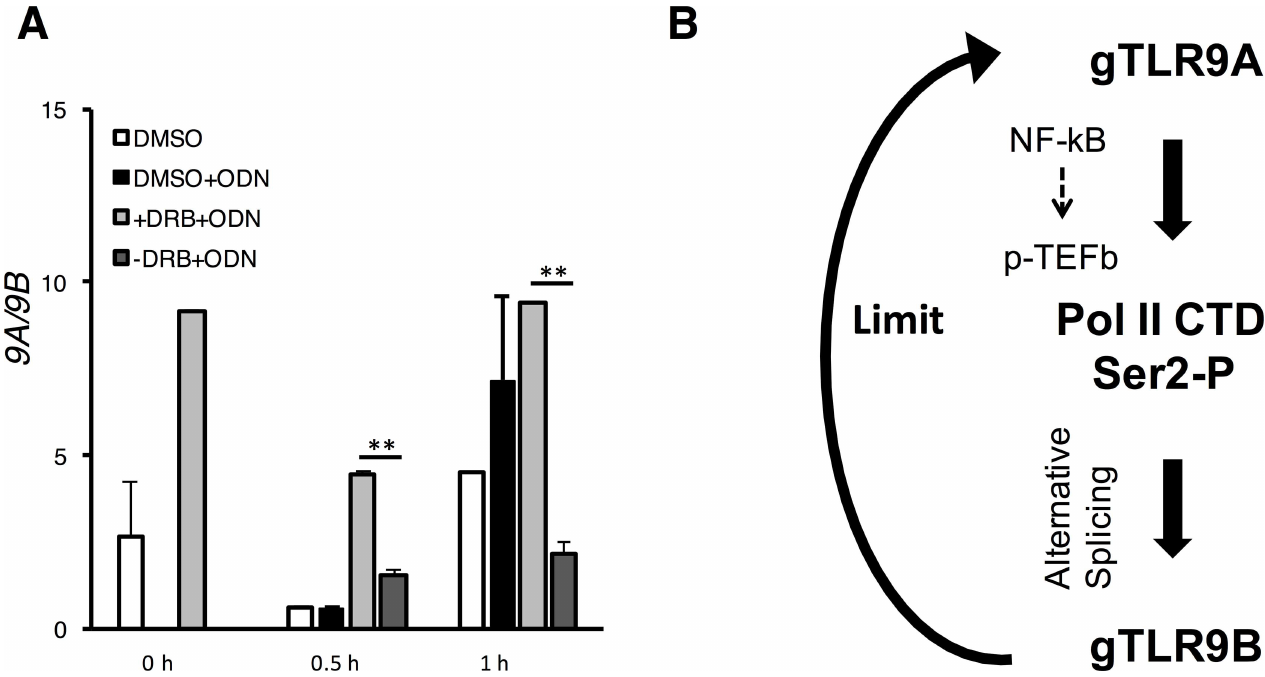
Fig 6. A working model for potential self-limiting regulation of gTlr9 alternative splicing. ( A ) Enriched macrophage were pre-treated with DRB and stimulated with ODN with or without the removal of DRB as previously describedin Fig 5. Increase of 9B was observedfrom 0.5 h and beyond. ( B ) Proposed mechanism of gTlr9 alternative splicing